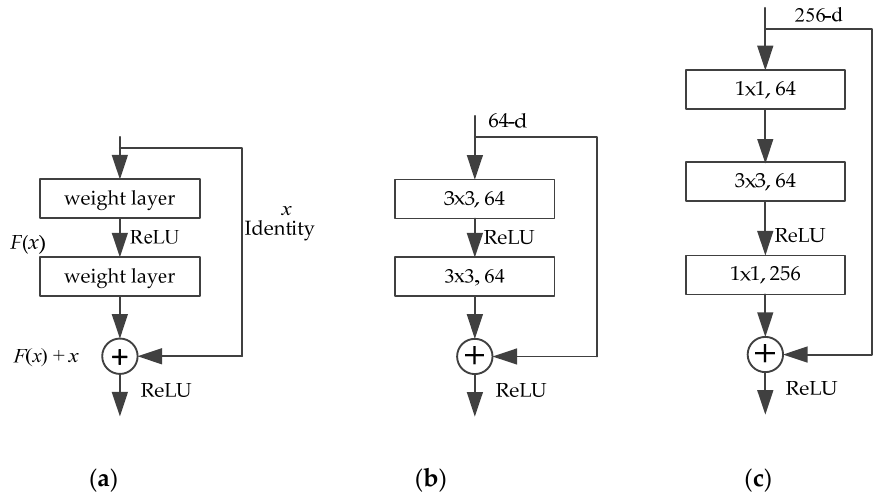
Figure 6. Design of shortcut connection structures of ResNet. ( a ) A building block. ( b ) ResNet34. ( c ) ResNet50/101/152.